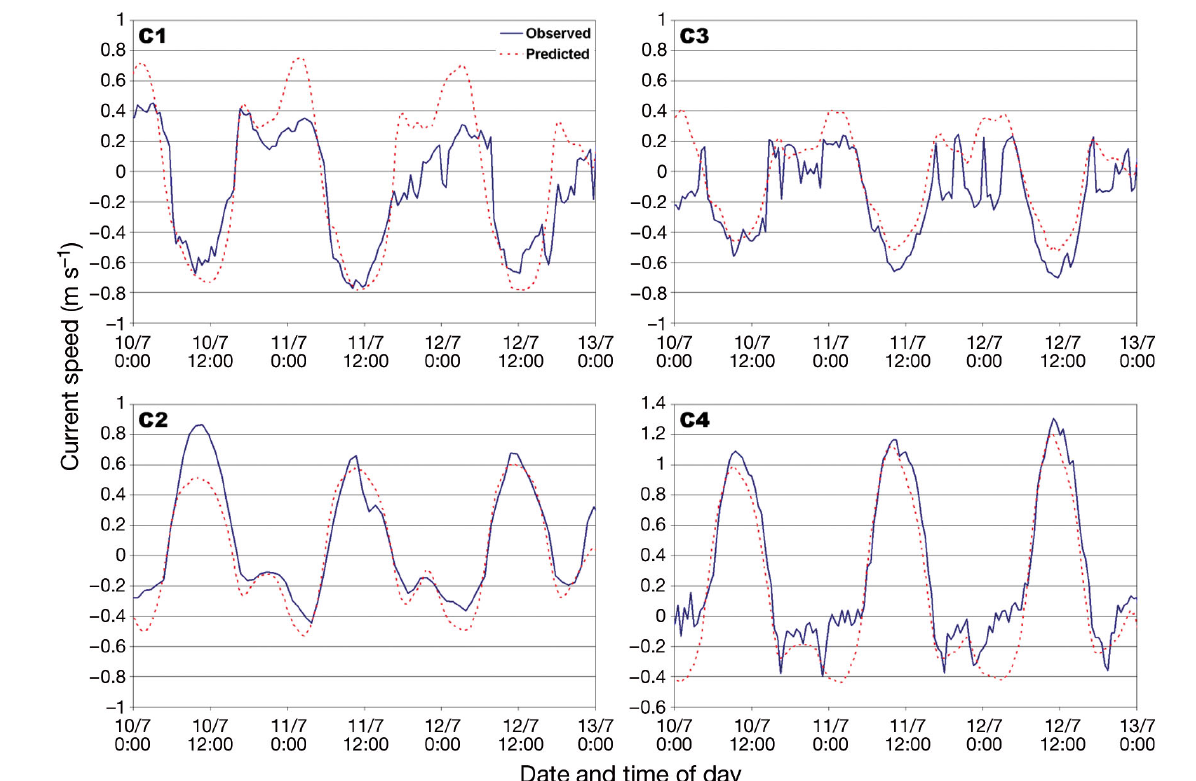
Fig. 3. Comparison of observed and model predicted time series of currents along their respective principal axis at the inner monitoring stations C1, 2, 3 and 4 (Fig. 2) in 2010. Dates are given as